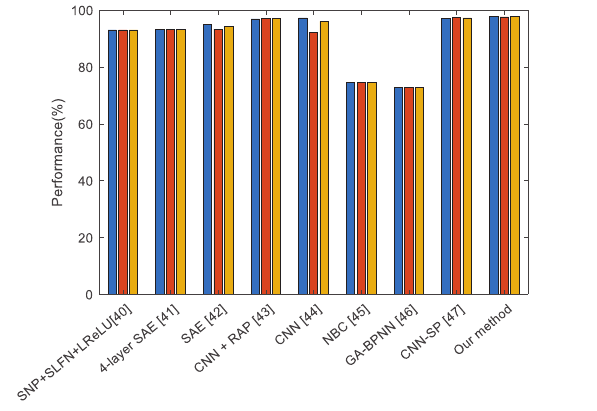
TABLE 3 | Measurements value CMB detection based on transfer learning of DenseNet (Units: %). Measurements